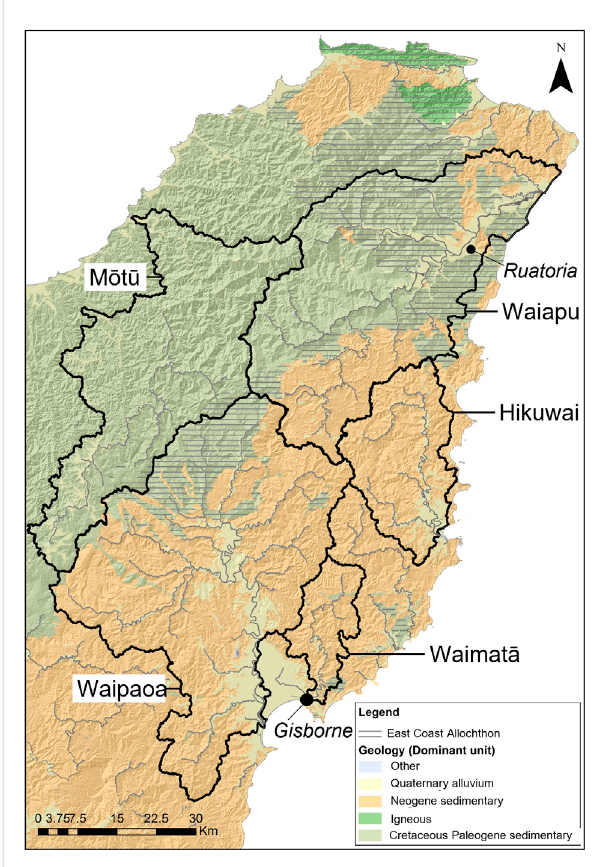
FIGURE 3 Geology of Tair ā whiti (East Coast Region of Aotearoa New Zealand). Cretaceous terrain is in green, Tertiary terrain is in orange, yellow denotes fl oodplains and alluvial terraces (note the prominence of Poverty Bay Flats at the mouth of the Waipaoa River). The East Coast Allochthon exerts a signi fi cant impact upon sediment fl ux in this region as it hosts badass gullies (gully-mass movement complexes that induce profound local input of sediment that overwhelms the valley fl oor — see Marden et al.,